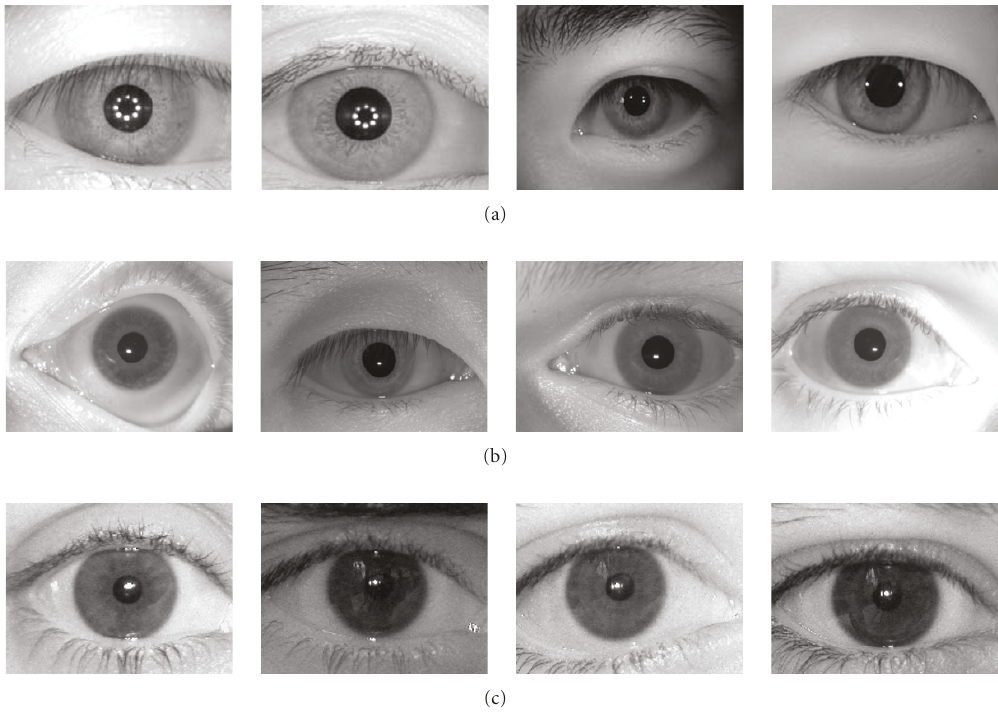
Figure 7: Some samples taken from (a) CASIA-IrisV3 database, (b) Bath database, and (c) Ubiris Version 1 database. × 10 4 8 . 5